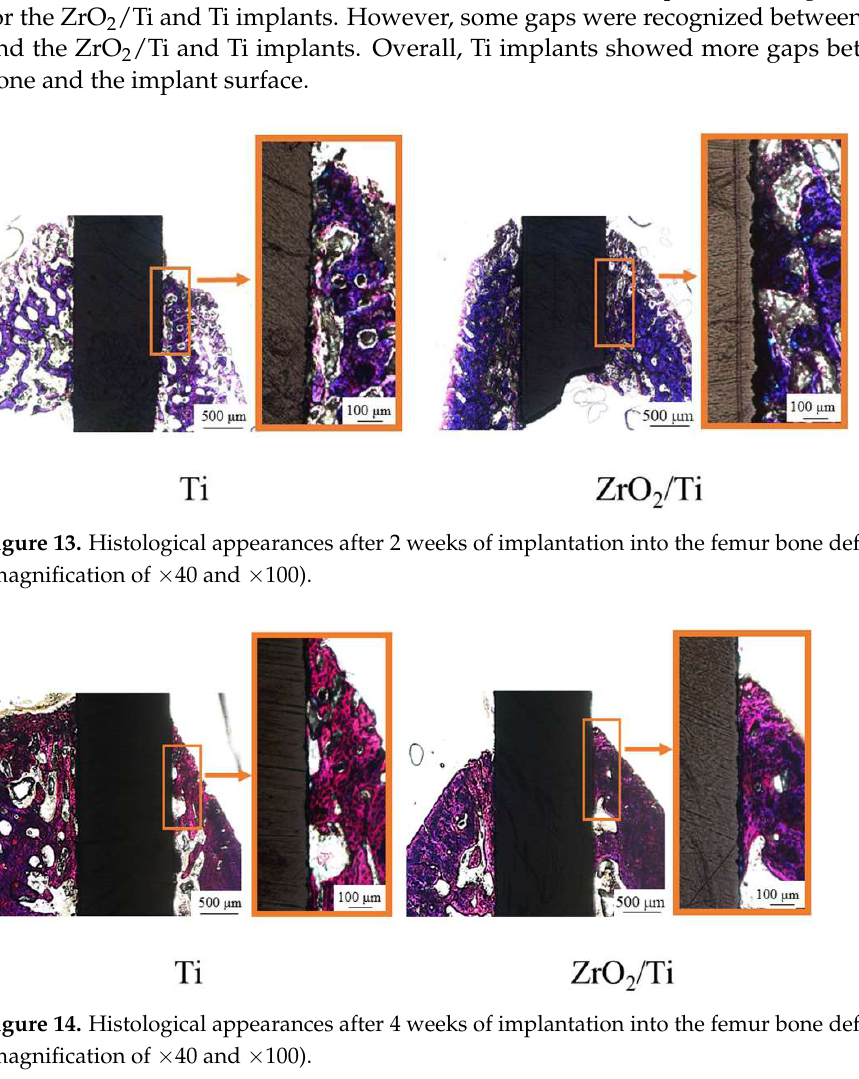
Figure 14. Histological appearances after 4 weeks of implantation into the femur bone defects of rats (magnification of ×40 and ×100).